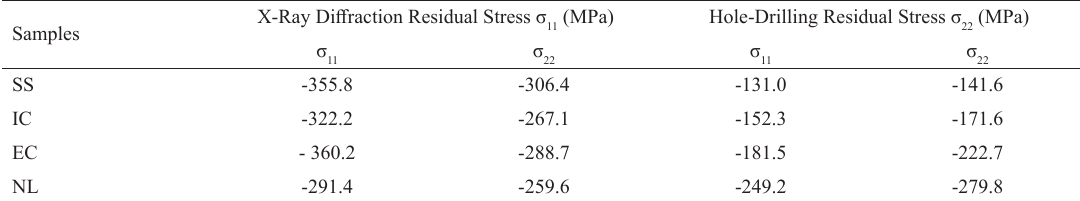
Comparison of the results of residual stress (σ measured by X-ray diffraction and by hole-drilling is made in Figures 2 and 3.